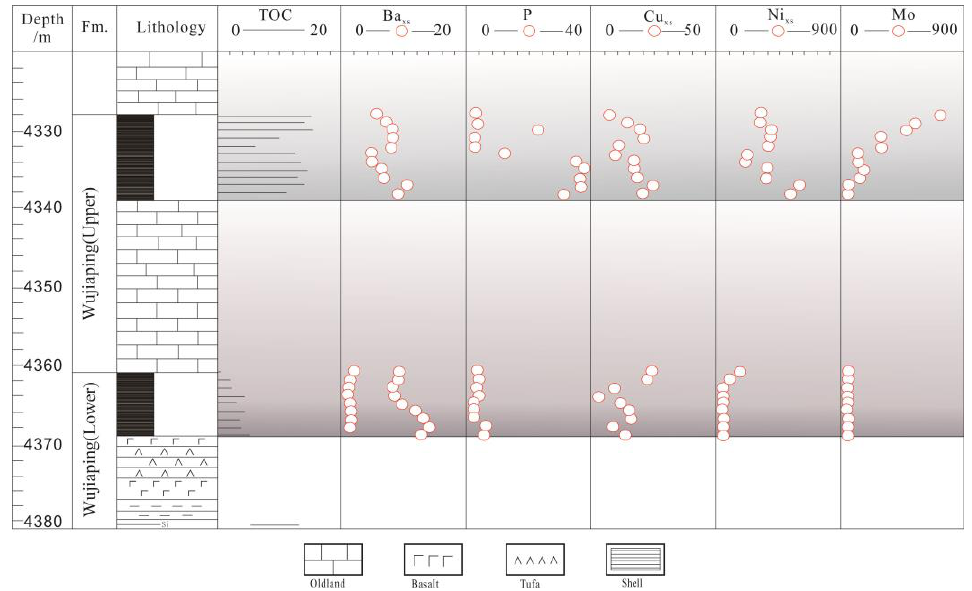
Figure 6. Distribution characteristics of shale productivity indicators in the Wujiaping Formation .